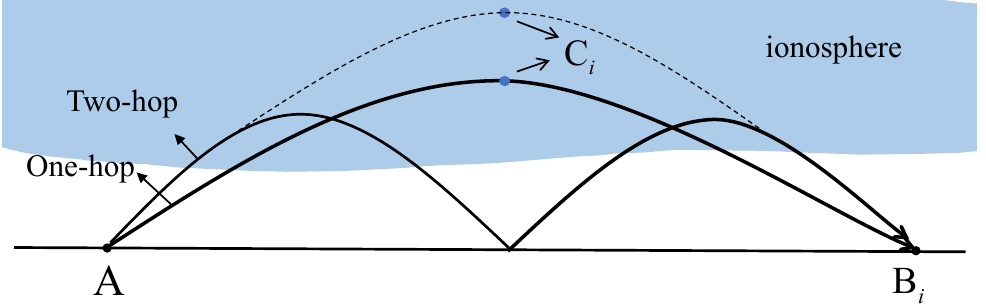
Figure 2. Schematic diagram of geometric relationship between the high-frequency (HF) source, the i th apogee and the i th